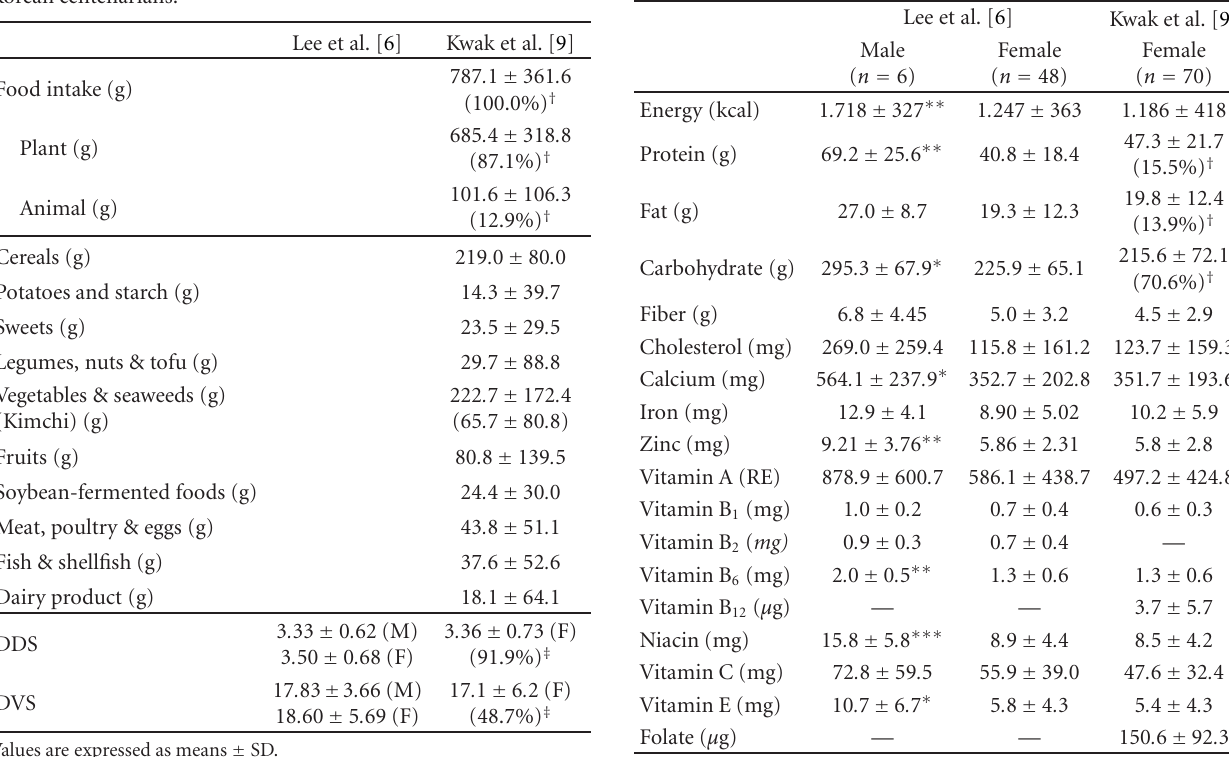
Table 4: Daily energy and nutrient intake of Korean